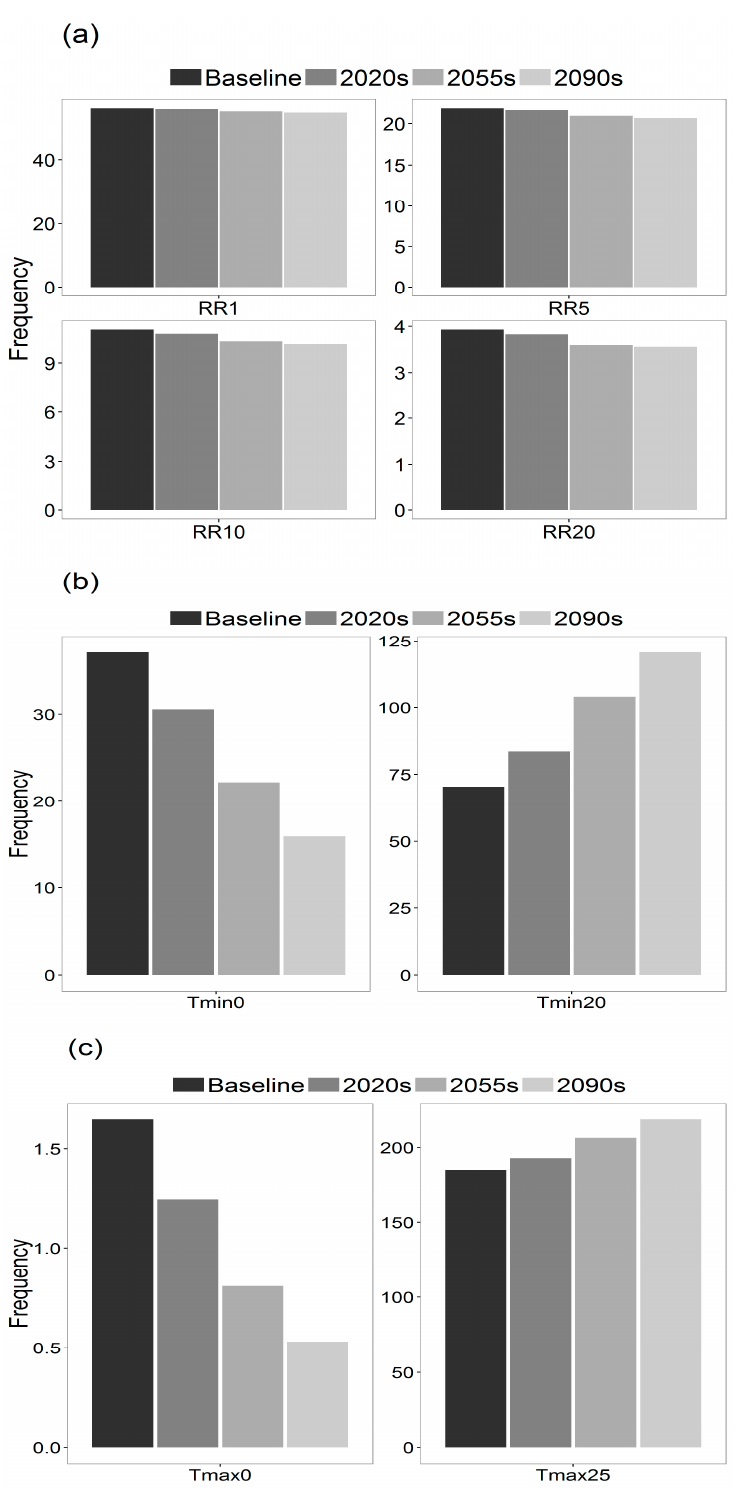
Figure 8. Frequency of climate indices for the baseline and future periods: precipitation ( a ); minimum temperature ( b ); and maximum temperature ( c ) indices.